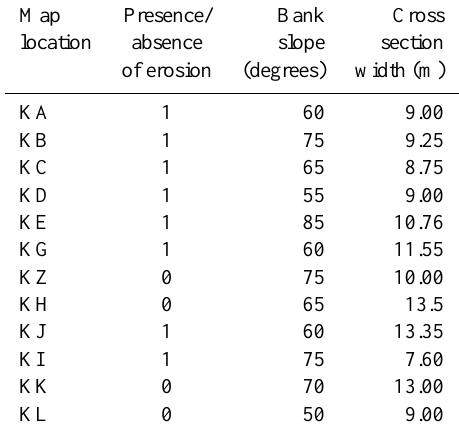
Table 2. Presence (1) or absence (0) of erosion at measurement lo- cations using a binary indication for the statistical model (LR and LWLR) setup based on inspection and BSTEM results. The third and fourth columns present the measured independent geomorpho- logical variables.